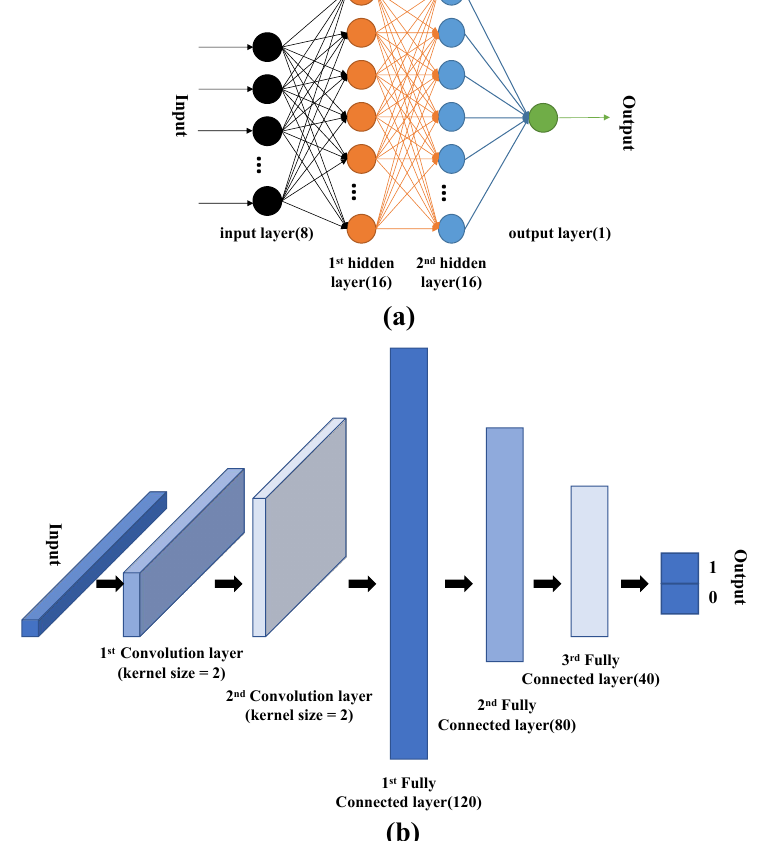
Figure 7. The structure of the MLP and CNN models. The number in parentheses after the layer name is the number of neurons contained in the layer. ( a ) Structure of the MLP, ( b ) structure of the